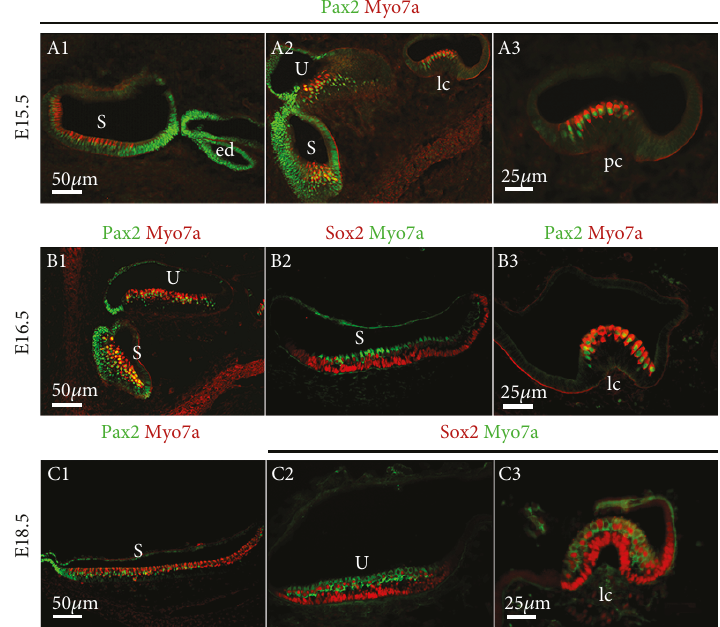
Figure 3: Comparison of Pax2 and Sox2 gene expression in the vestibule. Immuno fl uorescence of Pax2, Sox2, and myosin7a in the vestibule from E15.5 to 18.5. S: saccule; U: utricle; ed: endolymphatic duct; pc: posterior crista; lc: lateral crista. Scale bars =50 μ m (A1 – A2, B1 – B2,